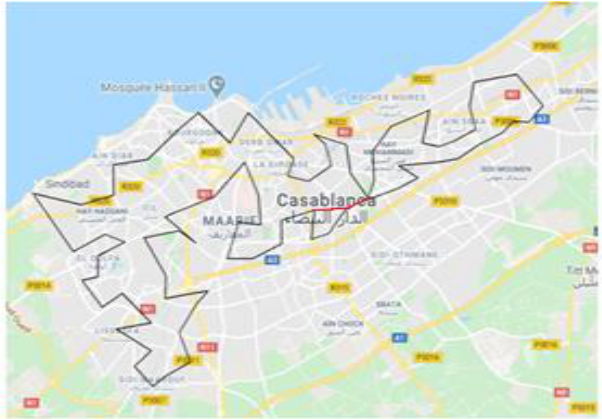
Fig 15. A map visualization of the tour returned by the GA with